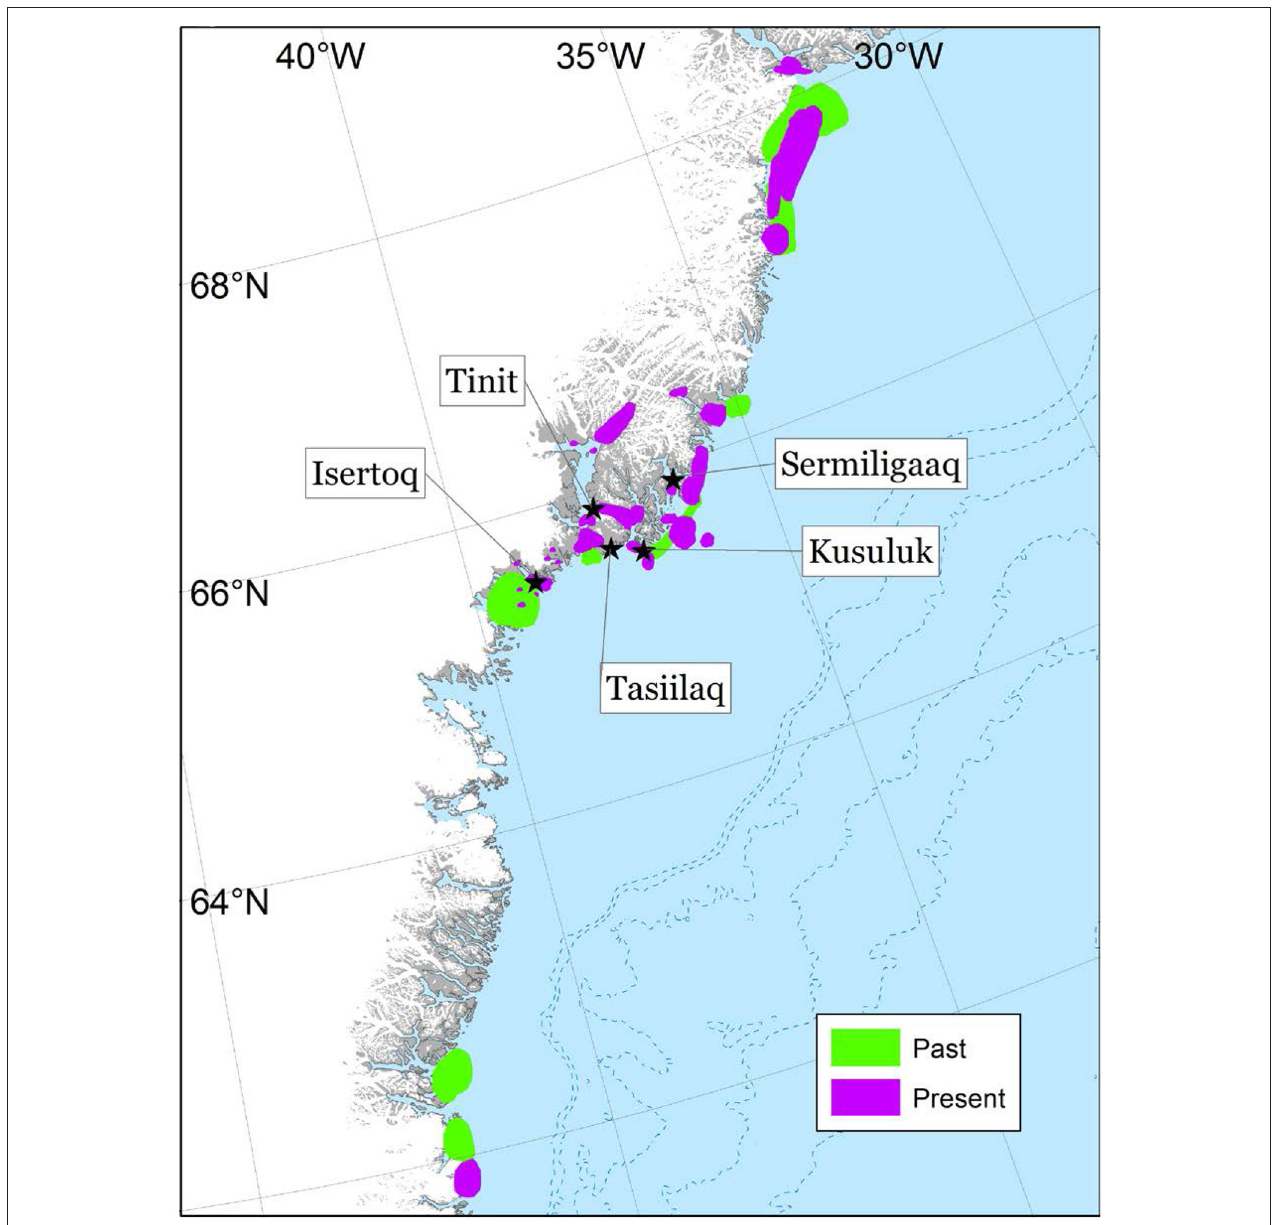
FIGURE 3 | Map of responses from Tasiilaq hunters ( n = 14) showing where they used to hunt bears 10–15 years ago, (“past” in green), and where they hunt bears now (“present” in purple).